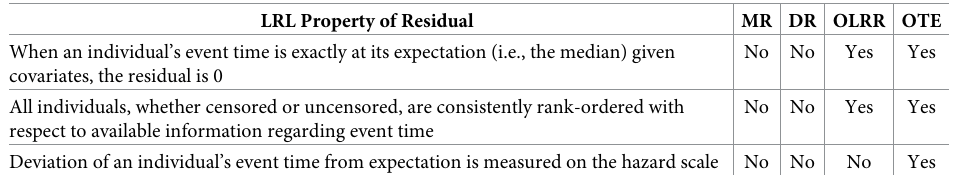
Table 1. Linear regression-like (LRL) properties for time-to-event